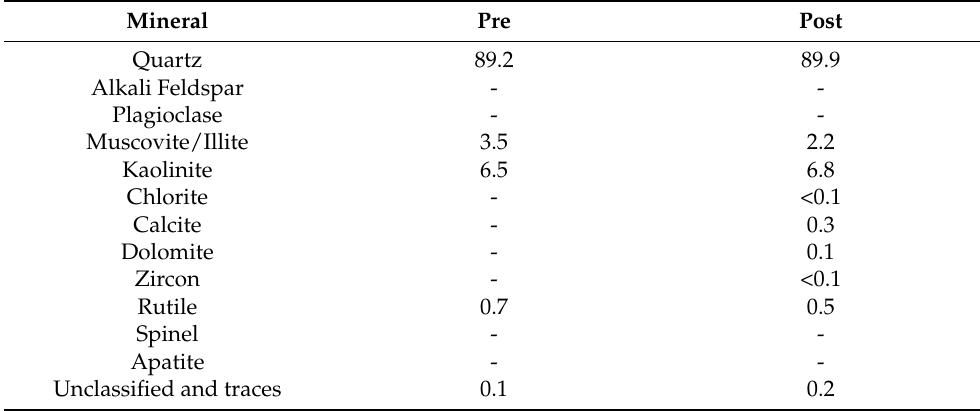
Figure 1. SEM-registered images of the sub-plug slice ( A ) tomogram, ( B ) mineral segmentation, ( C ) SEM, and ( D ) QEMSCAN and mineral legend. Table 3. Pre- and post-reaction modal mineralogies (area%) from QEMSCAN of the polished sub-plug slice.